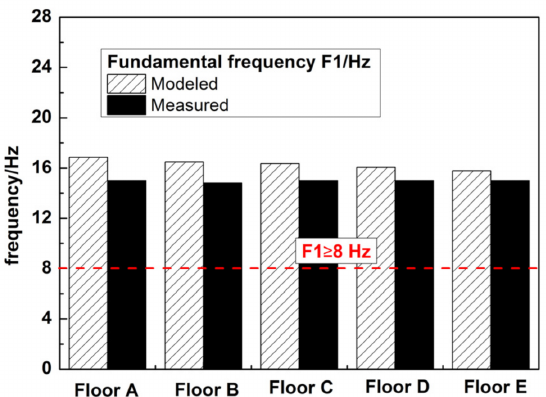
Figure 10. Fundamental frequencies obtained from the experiment and the models.